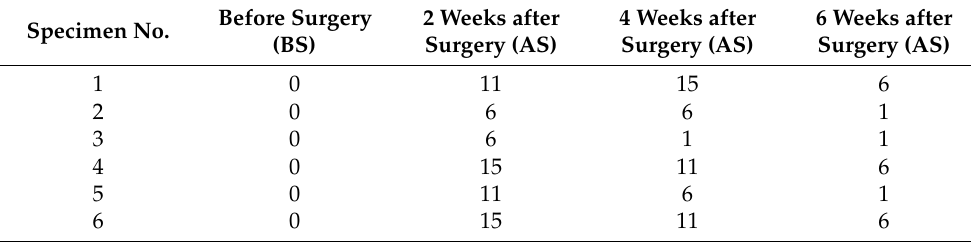
Table 6. Clinical score distribution across group